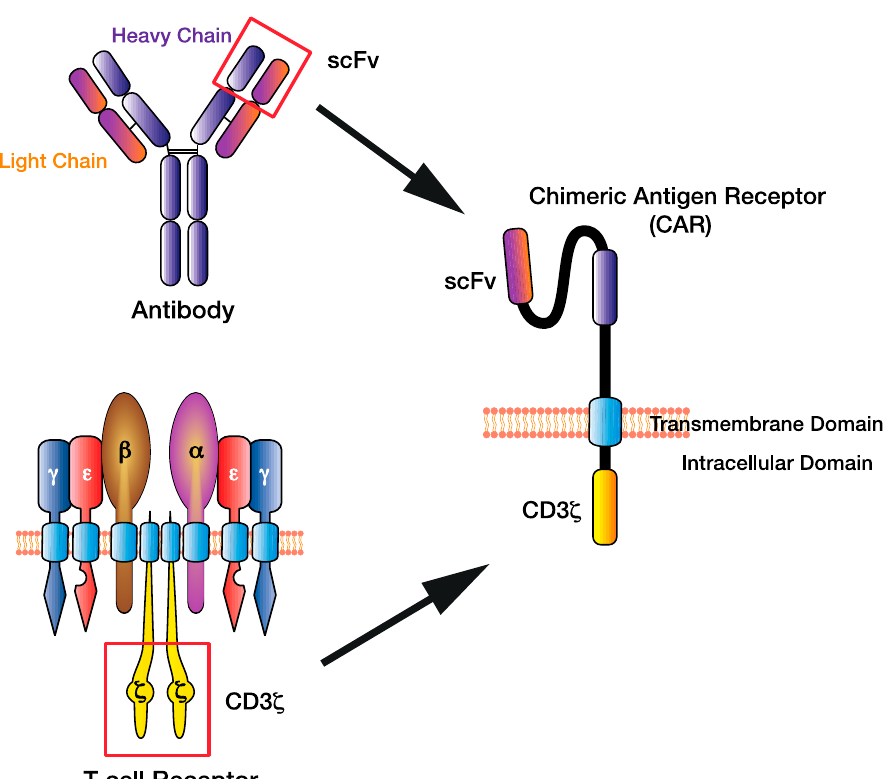
Figure 1. The chimeric antigen receptor (CAR) T cell design has evolved by combining existing immune cell components to facilitate direct targeting of tumour antigens. The single-chain variable fragment (scFv) of the CAR derived from the heavy and light chains of the antibody variable region, while the CAR CD3 ζ domain is derived from the T cell receptor intracellular signalling domains.